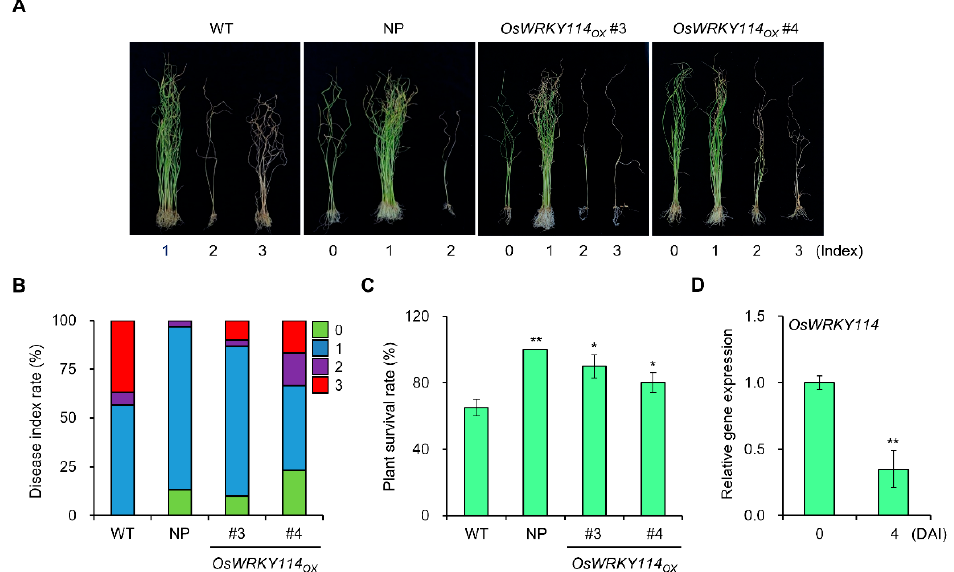
Figure 2. OsWRKY114 increases resistance to Fusarium fujikuroi . ( A – C ) Bakanae disease assay of OsWRKY114 OX . Four-day-old OsWRKY114 OX , bakanae disease-resistant variety Nampyeong (NP), and wild-type (WT) seedlings were inoculated with F. fujikuroi CF283. Images were acquired 21 days after inoculation ( A ) and disease index ( B ) and survival rate ( C ) were calculated. Disease index: 0, no symptoms appeared; 1, blight symptoms appeared on leaf tips; 2, shoots wilted and leaf color changed to pale green; 3, the whole leaf dried out. Values represent means ± SD. Asterisks indicate values signi fi cantly di ff erent from those of the WT control (* p < 0.05 and ** p < 0.01). ( D ) Relative expression levels of OsWRKY114 after F. fujikuroi inoculation. Four-day-old WT seedlings were inoculated with F. fujikuroi CF283 for 4 days. Total RNA was extracted from the seedlings before and after F. fujikuroi inoculation. Transcript levels of OsWRKY114 were analyzed by RT-qPCR. OsActin was used as an internal control to quantify relative gene expression. Values are expressed as means ± SD. Asterisks indicate values signi fi cantly di ff erent from those of the mock-inoculated control (** p < 0.01). All experiments were repeated at least three times, and similar results were obtained. Representative graphs are shown.